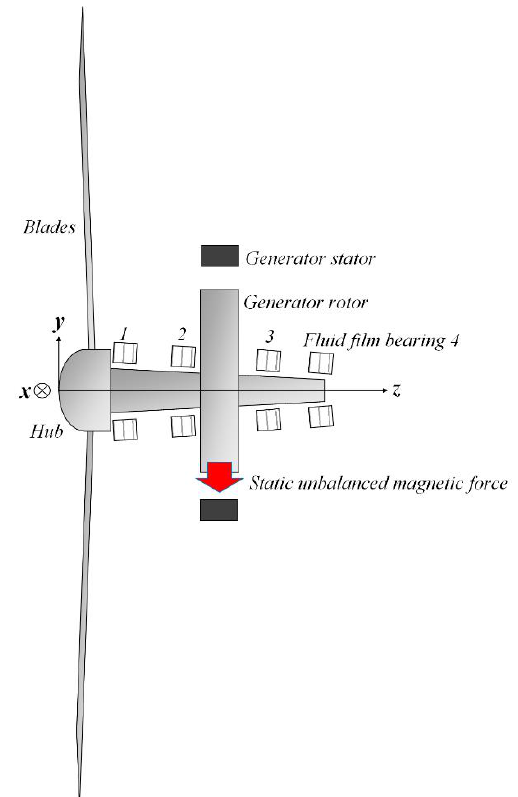
Figure 2. Schematic of a fluid-bearing-supported 10 MW direct-drive wind turbine drive shaft.